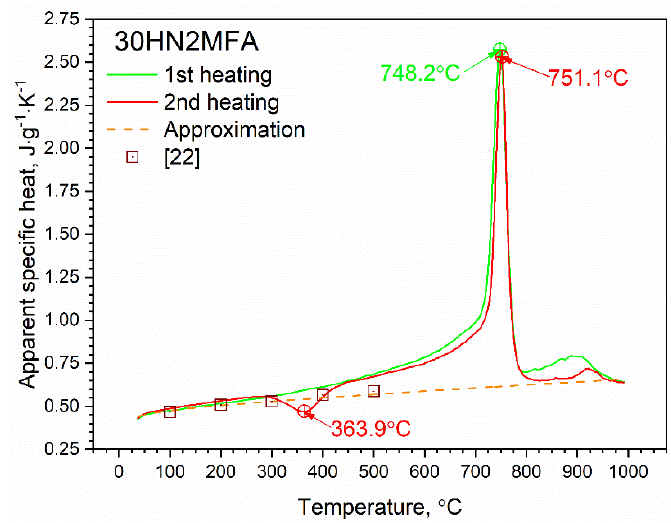
Figure 5. Results of apparent specific heat for 30HN2MFA steel (own research vs. literature data [22]).